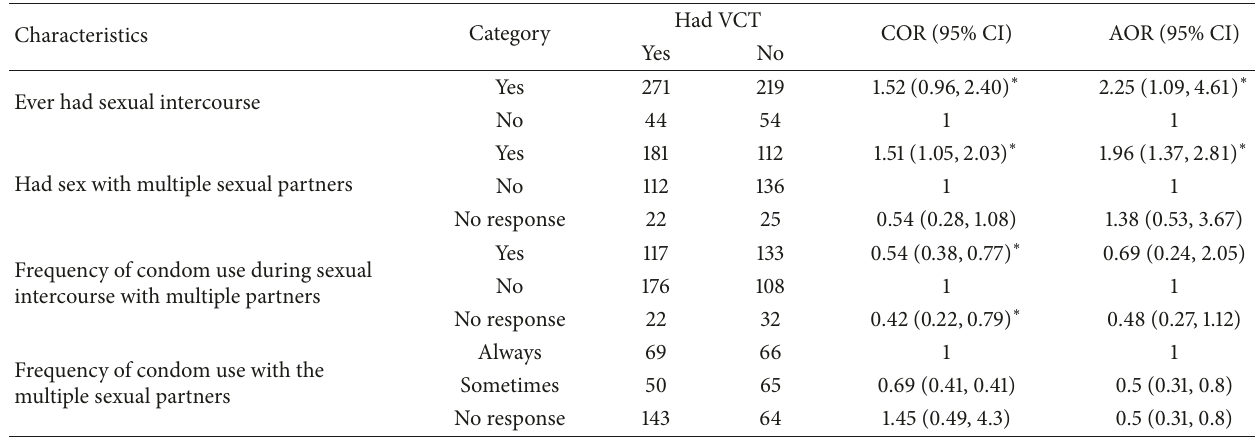
Table 5: Association of sexual behaviors with VCT service utilization among secondary school teachers in Awi Zone, Amhara Region, Ethiopia, 2014.